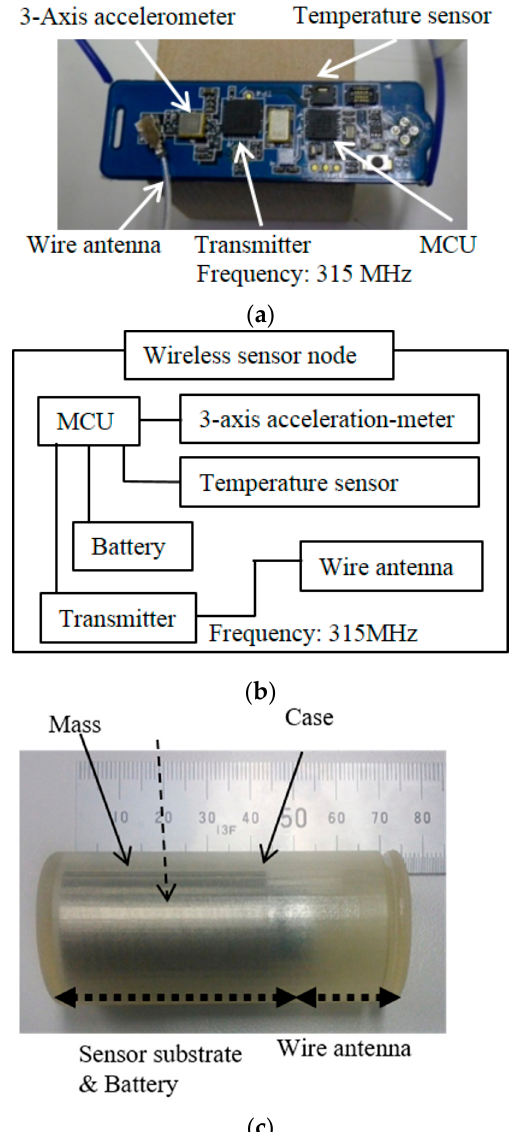
Figure 3. Photograph of the sensor substrate ( a ); a block diagram of it ( b ); and a photograph of our bolus-type wireless sensor node ( c ).